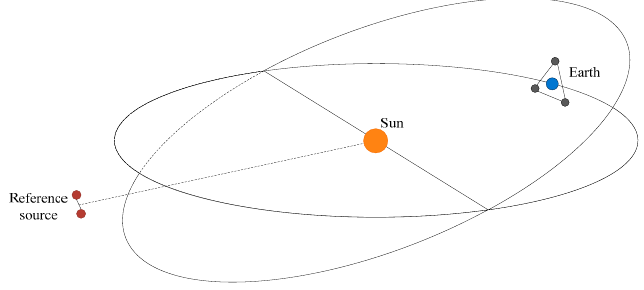
Figure 3. Illustration of preliminary concept of TianQin mission.